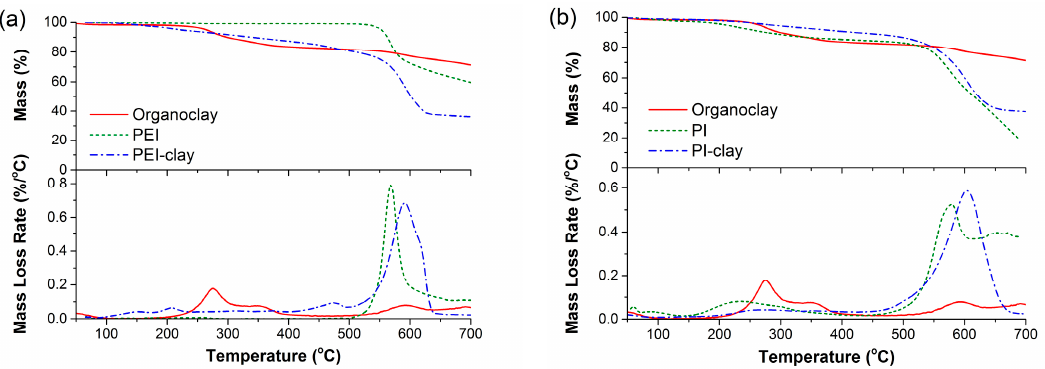
Figure 3. Thermogravimetric curves under oxidative conditions: ( a ) organoclay, PEI, and PEI-coated clay; and ( b ) organoclay, PI, and PI-coated clay.